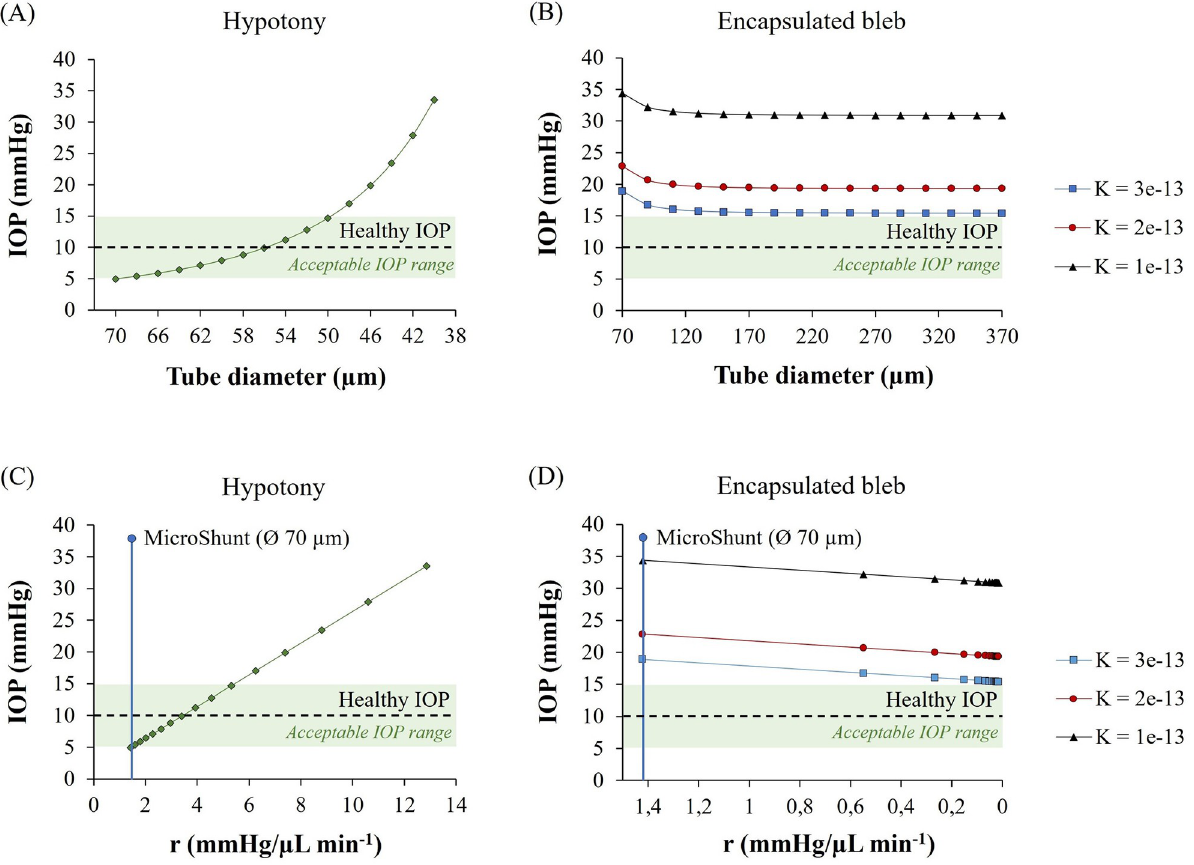
Fig 9. Model prediction of the IOP with varying MicroShunt lumen diameters. (A) and (B) –IOP variation with varying MicroShunt lumen diameter in case of hypotony and encapsulated bleb, respectively. (C) and (D) –Hydrodynamic resistance ( r ) of the different lumen-diameter MicroShunts and its impact on the final IOP. The shaded green area represents an acceptable IOP range of 5–15 mmHg.